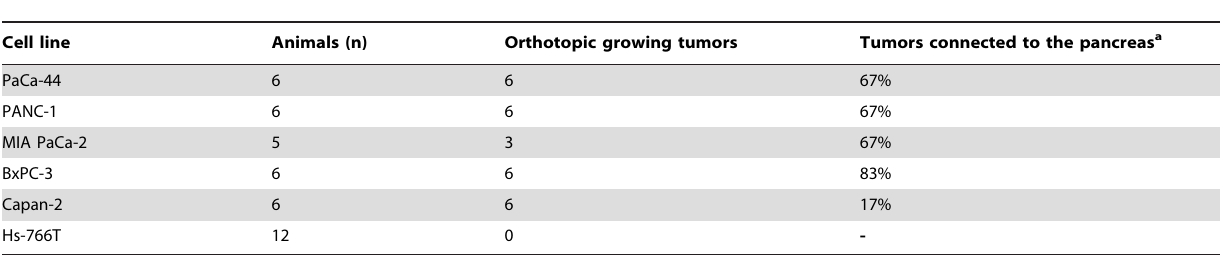
Table 2. Summary of orthotopical tumor